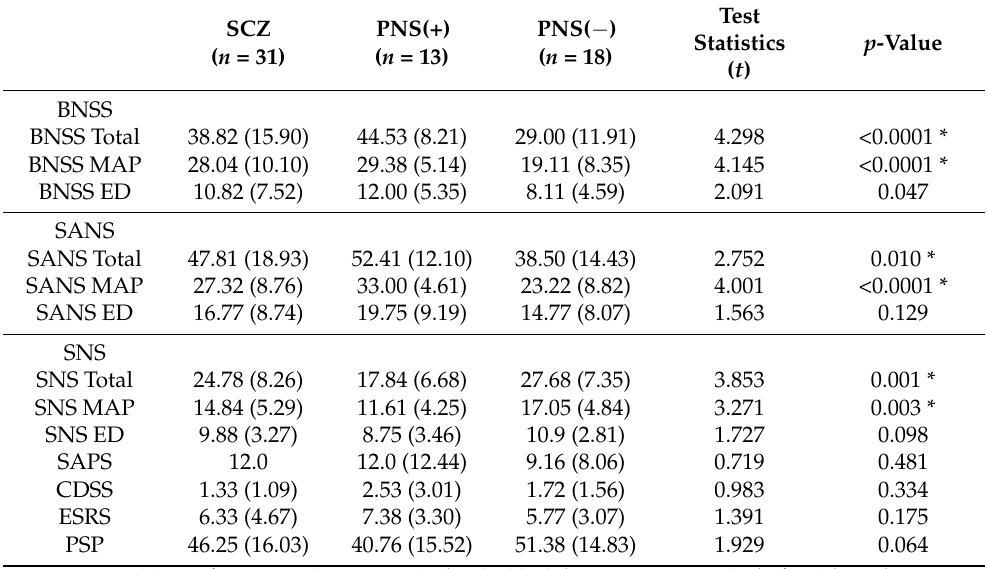
Table 2. Mean clinical scale scores and their comparisons between patients with and without PNS.